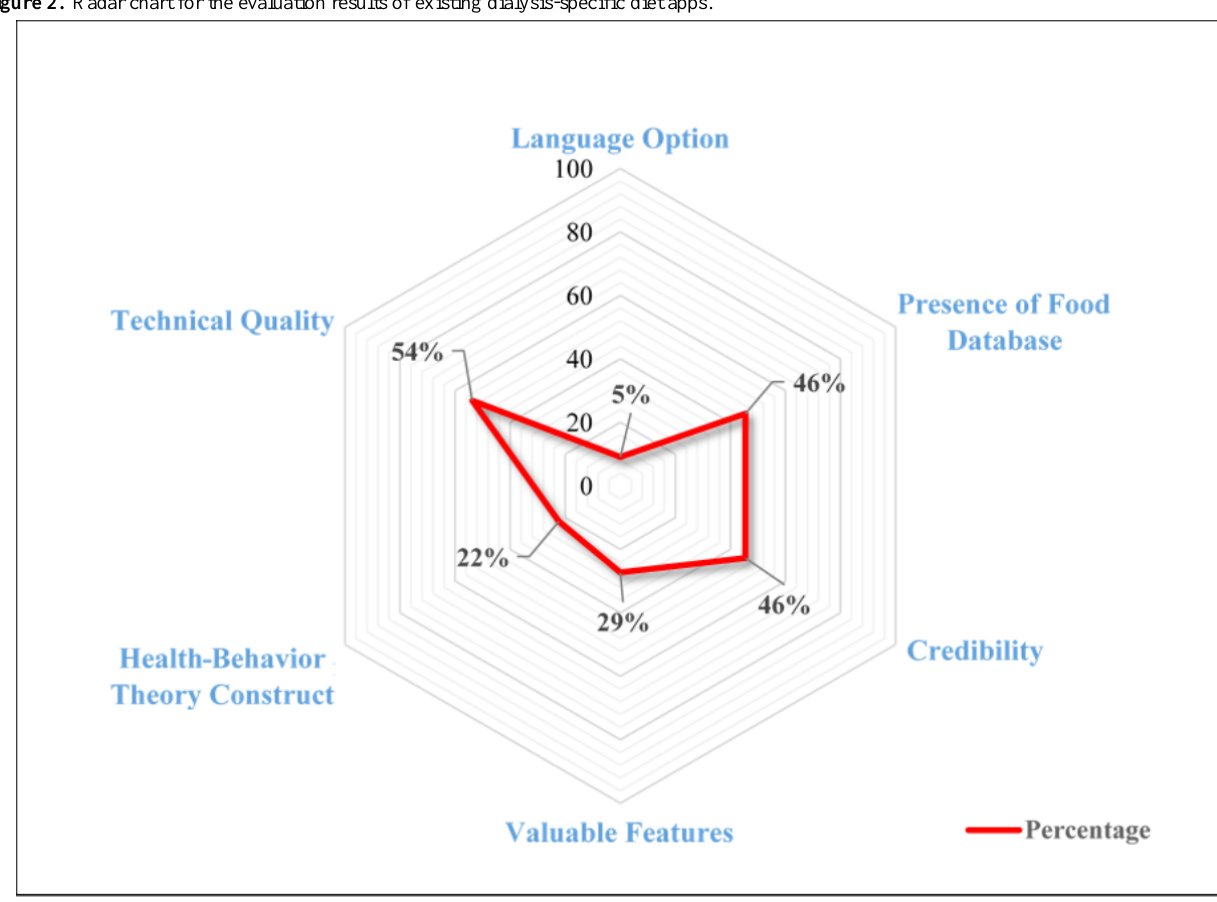
Figure 2. Radar chart for the evaluation results of existing dialysis-specific diet apps.